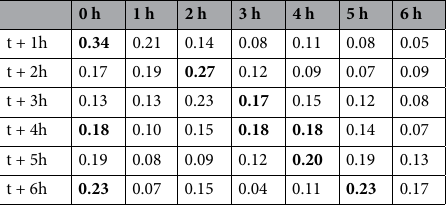
Table 5. The row-normalized fractions of the DTW measure for the network trained with the reweighted data. Best results are in [bold].